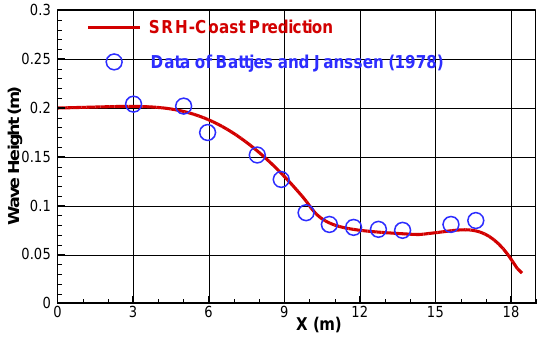
Figure 10. Comparison of the predicted wave height with the experimental data of Battjes and Janssen